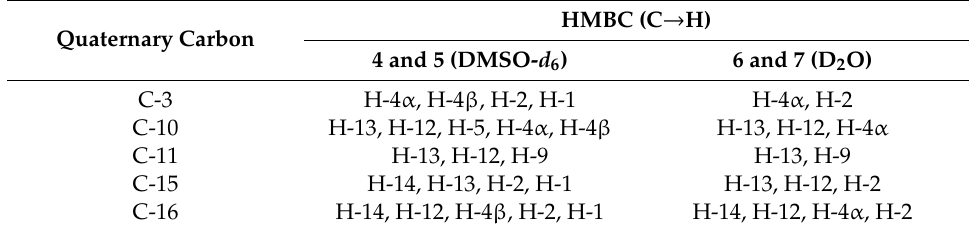
Table 4. Long range couplings of hydrogen with quaternary carbon atoms observed in the HMBC spectra of compounds 4 – 7